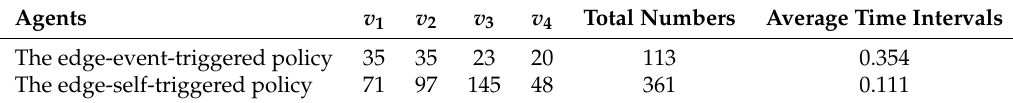
Figure 4. Simulation results of edge-self-triggered control. ( a ) State trajectories of all individuals. ( b ) Update times of all controllers. ( c ) Update values of all controllers. Table 1. Comparisons of the triggering numbers of each agent in the time interval t ∈ [ 0,10 ] .